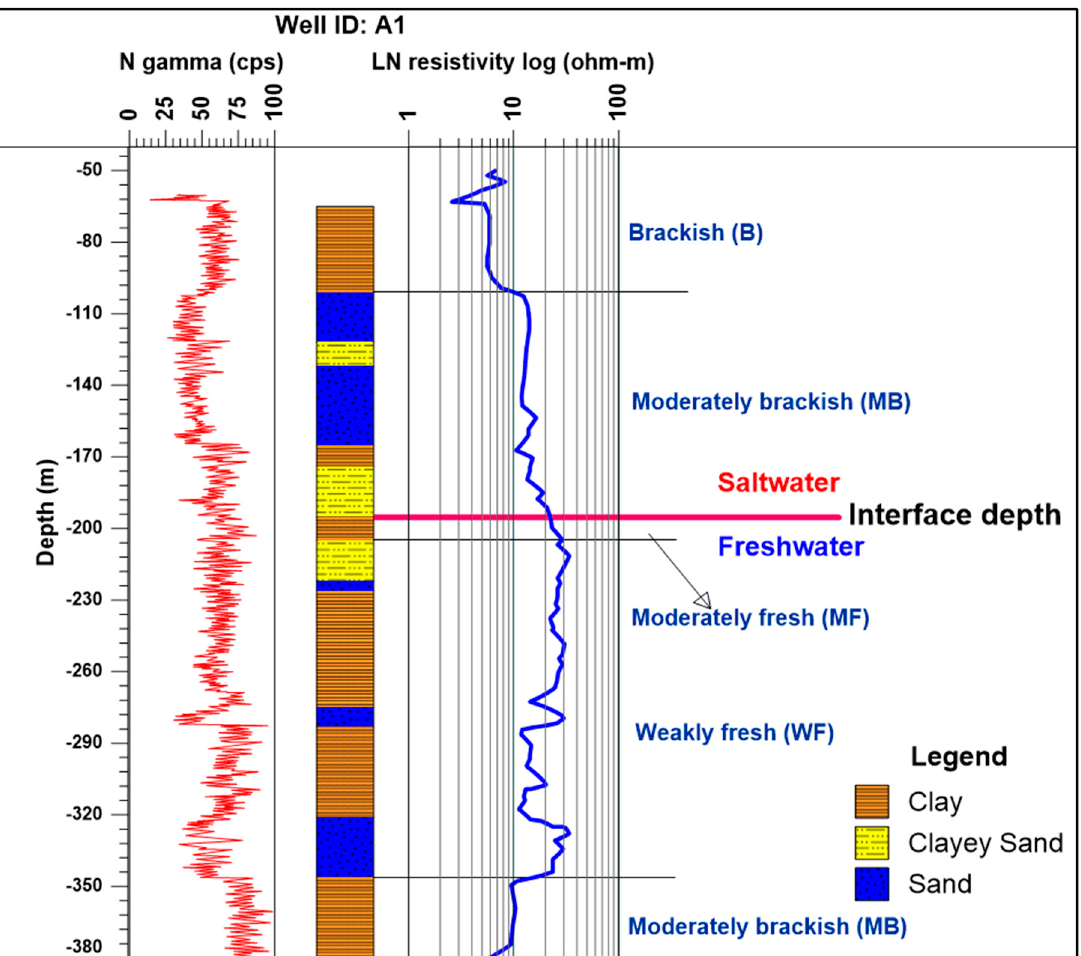
Figure 3. An example delineation of saltwater–freshwater interface in well